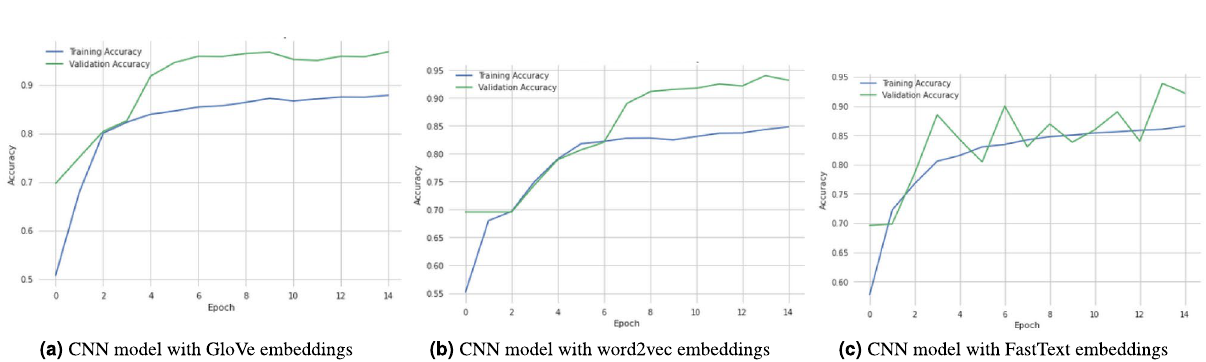
Figure 2. Models training and validation accuracy with word embeddings using the religious toxic comments dataset.